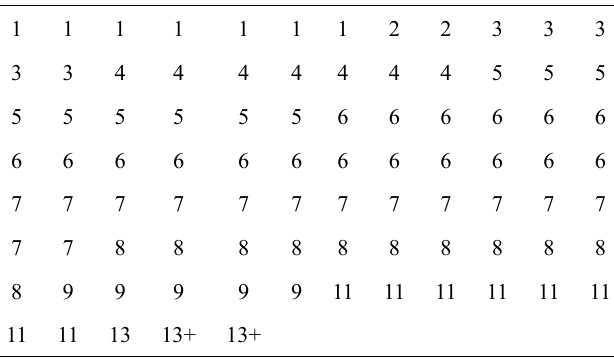
Dataset related to the agricultural machine’s corrective maintenance (+ indicates